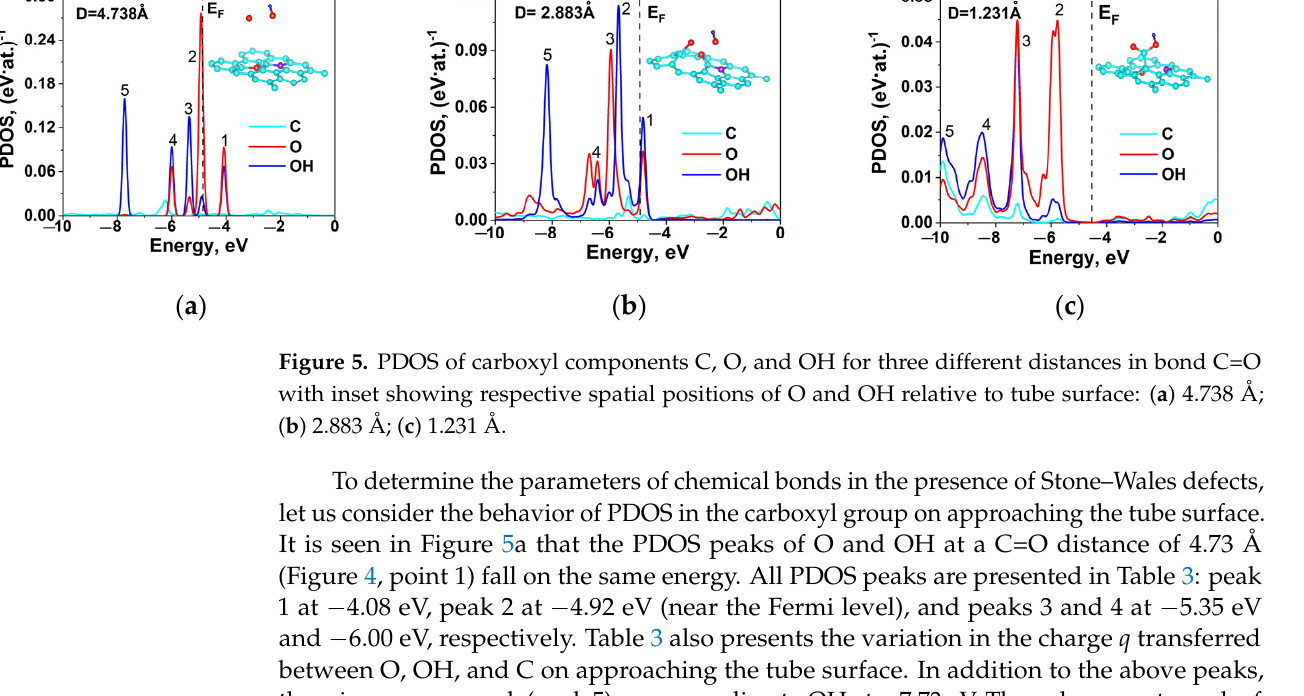
Figure 5. PDOS of carboxyl components C, O, and OH for three different distances in bond C=O with inset showing respective spatial positions of O and OH relative to tube surface: ( a ) 4.738 Å; ( b ) 2.883 Å; ( c ) 1.231 Å.